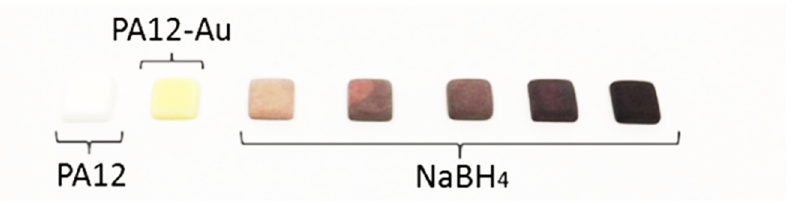
Figure 6. Polyamide adsorbent used for gold recovery and catalysis. PA12 is the unused adsorbent, PA12-Au is the adsorbent after gold recovery. NaBH 4 indicates the Au 0 loaded PA12 after reduction by NaBH 4 . Reproduced with permission from [69,70].